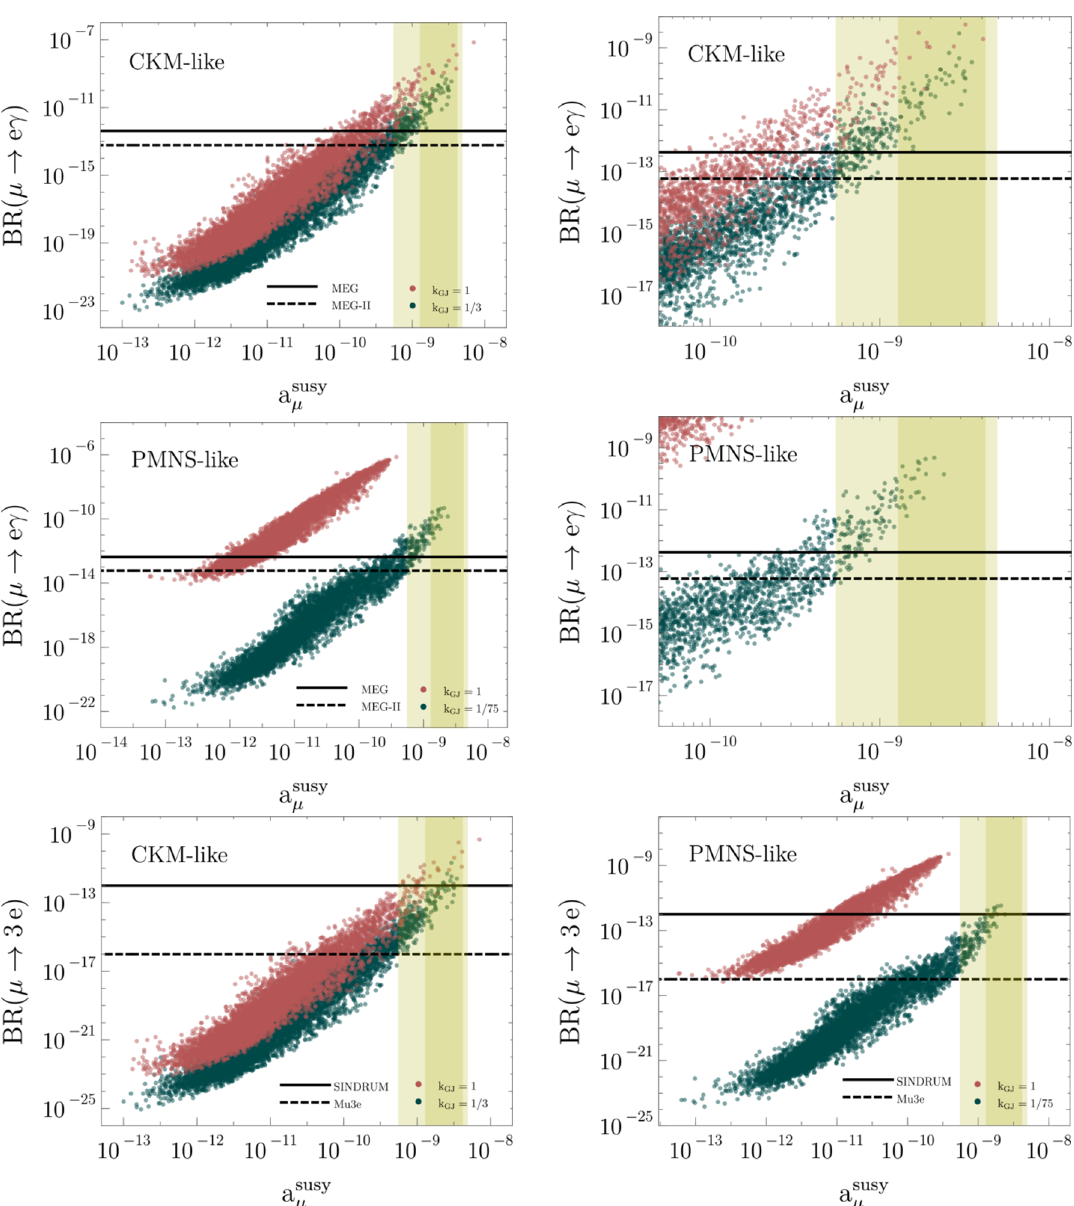
Figure 6 . Top: BR( (cid:22) ! e (cid:13) ) versus the supersymmetric contribution to the anomalous magnetic moment of the muon in the CKM-like case. The right panel is a magni(cid:12)cation of the region of interest. Red/light points correspond to k GJ = 1 while green/dark points to k GJ 6 = 1. The black (dashed) line signals the current (future) limit from MEG (MEG-II) . Middle: the same as before but in the PMNS-like case. Bottom: BR( (cid:22) ! 3e) versus the supersymmetric contribution to the anomalous magnetic moment of the muon in the CKM-like (left) and PMNS-like (right) cases. The black (dashed) line signals the current (future) limit from SINDRUM (Mu3e) .